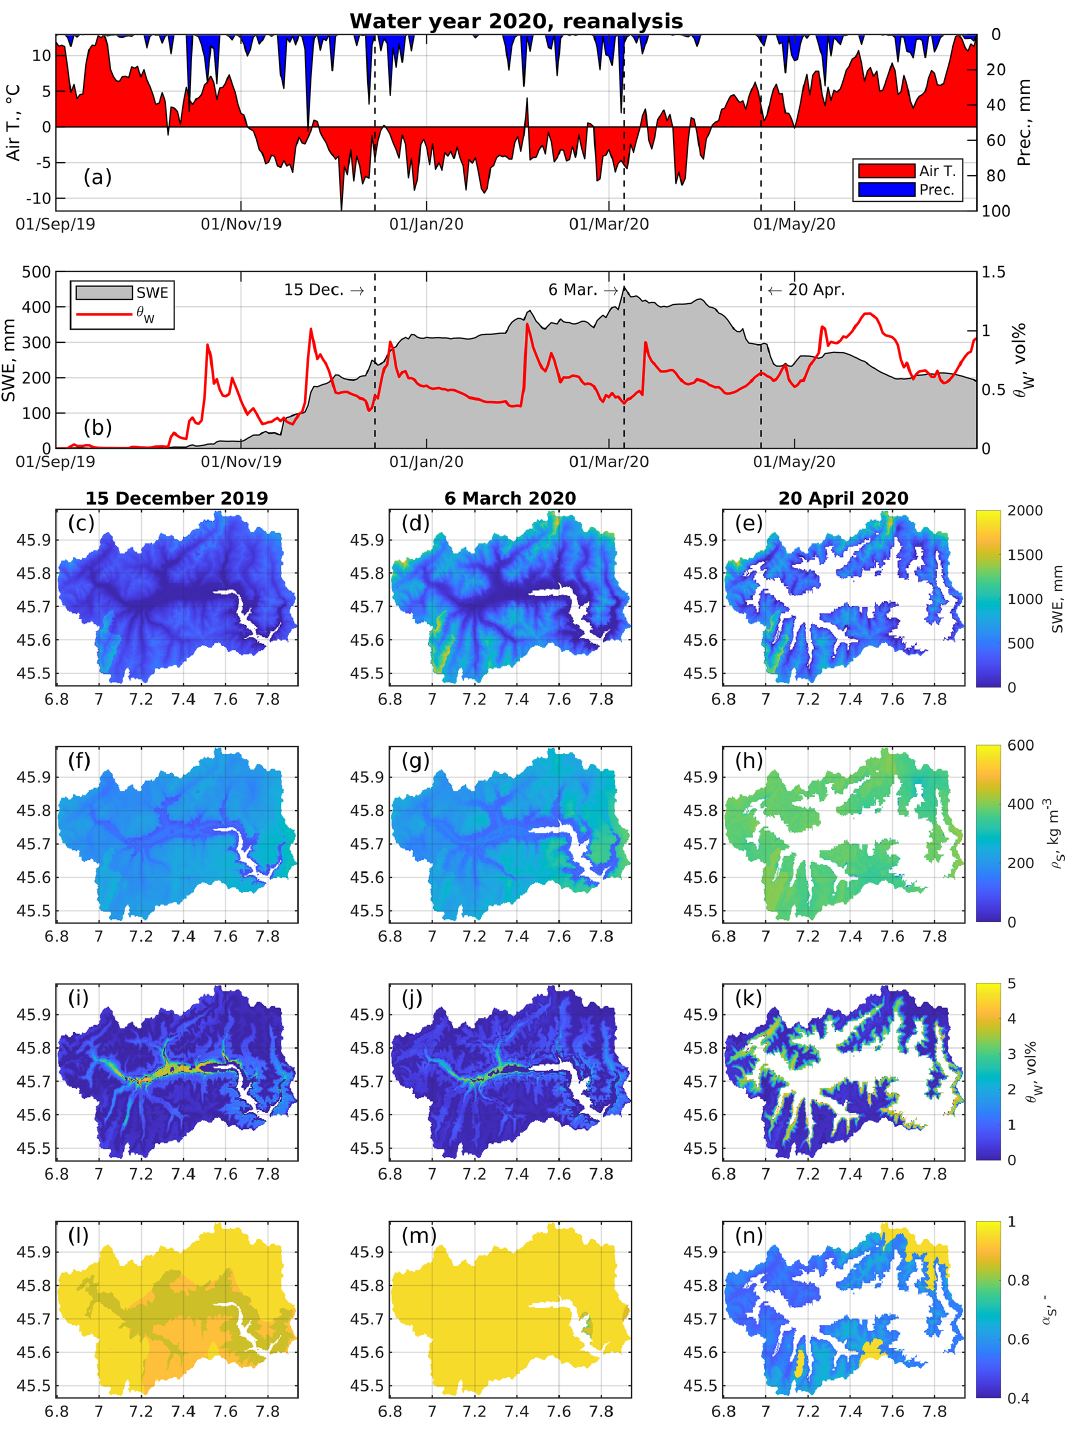
Figure 7. Simulated reanalysis of the 2020 snow season: spatially averaged air temperature and total precipitation (a) , spatially averaged SWE and bulk liquid-water content θ W (b) , and distribution of SWE (c–e) , bulk snow density ρ S (f–h) , bulk liquid water content (i–k) , and albedo α S (l–n) for three example dates: 15 December 2019 (first column), 6 March 2020 (middle column), and 20 April 2020 (third column). Statistics in panels (a) and (b) are spatial averages across the entire Aosta Valley